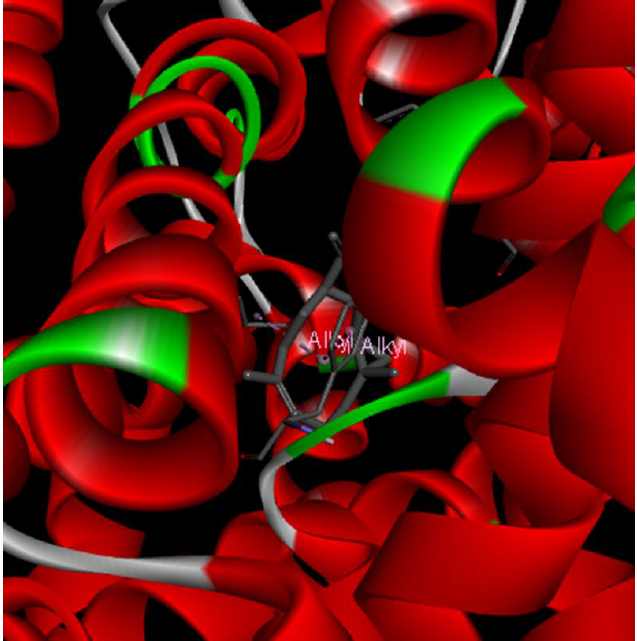
Figure 11. The putative interactions between parthenolide and the dopamine transporter [DAT; Protein Data Bank ID (PDB): 4XNX_1]. The free energy of binding (ΔG) and affinity (Ki) were −8.6 kcal/mol and 0.6 µM, respectively.